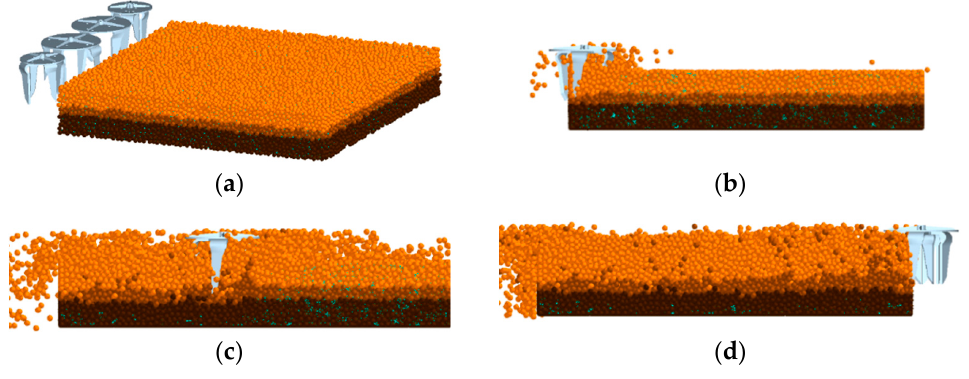
Figure 8. Simulation process diagram ( a ) 4.0 s; ( b ) 4.3 s; ( c ) 5.1 s; ( d ) 5.6 s.